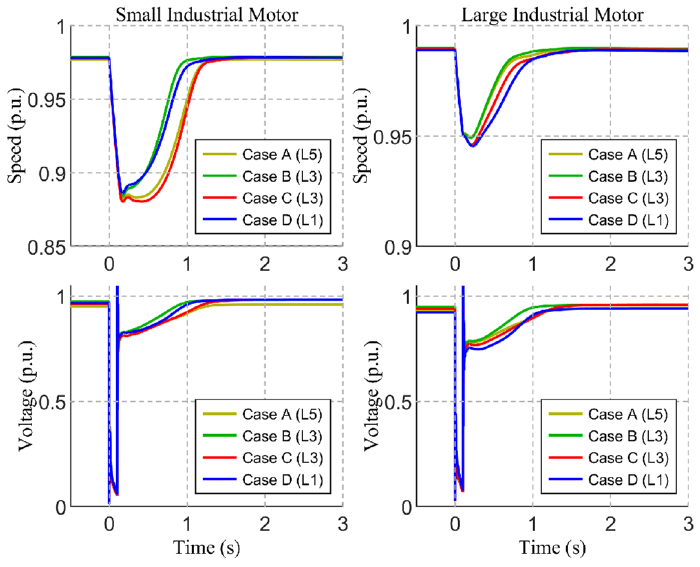
Figure 25. WF1 reactive current output and terminal voltage considering different IM load percentages.